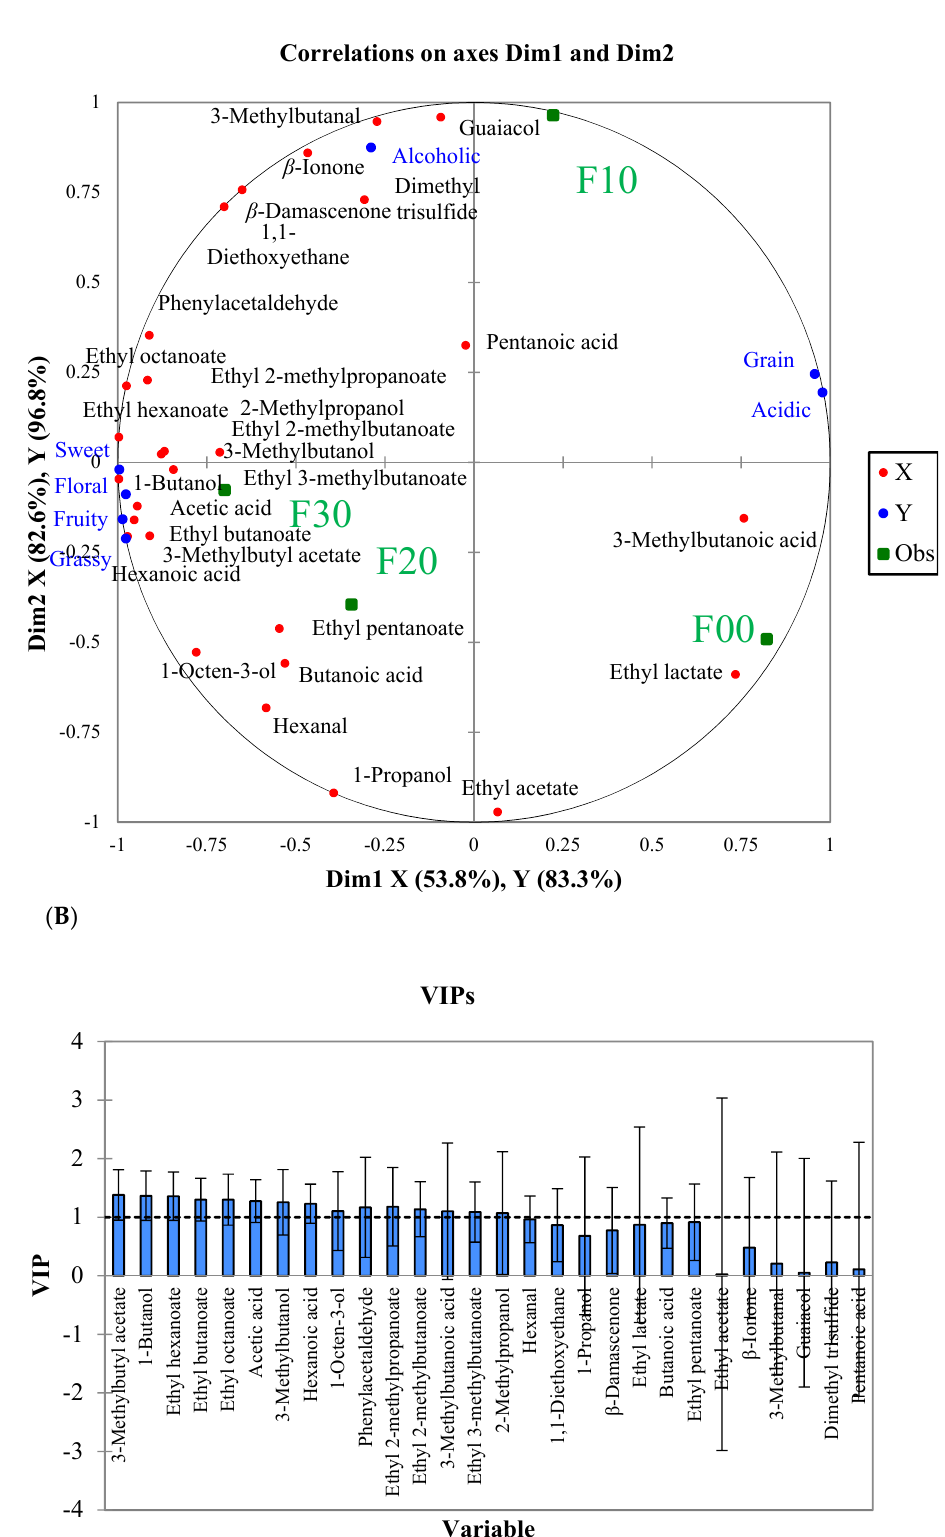
Figure 4. ( A ) Correlation loading plot between the aroma compounds with OAVs >1 (X) and orthonasal aroma attributes (Y) among the four different grades of FJ (Obs). ( B ) Variable importance for the projection (VIP) values for 28 aroma compounds (OAVs >1).